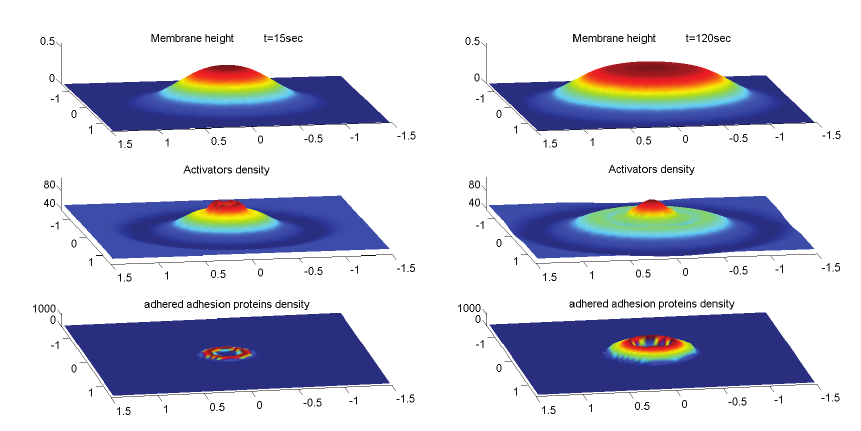
Figure 7. Numerical integration of Equation (15) for the case of constitutive active activators over a period of 2 min over a membrane segment of size 5 × 5 µ m 2 . The parameter values used were the same as used previously, with the following changes: A = 1.9 · 10 − 5 kg · µ m 5 · sec − 2 , D g = 0.1 µ 2 /sec, = 0.05 µ m 5 /sec, k g = 1 µ m 2 /sec, l = 0.04 µ m and g = 50 µ m − 2 (the initial uniform k g 0 0 on ,0 of f ,0 concentration of the free adhesion proteins). The perturbation develops into a protrusion and when it reaches the wall the activators at the core start expanding into a ring but this expansion is inhibited by the adhesion ring that forms around it. The actin core is then trapped by the adhesion ring and the structure